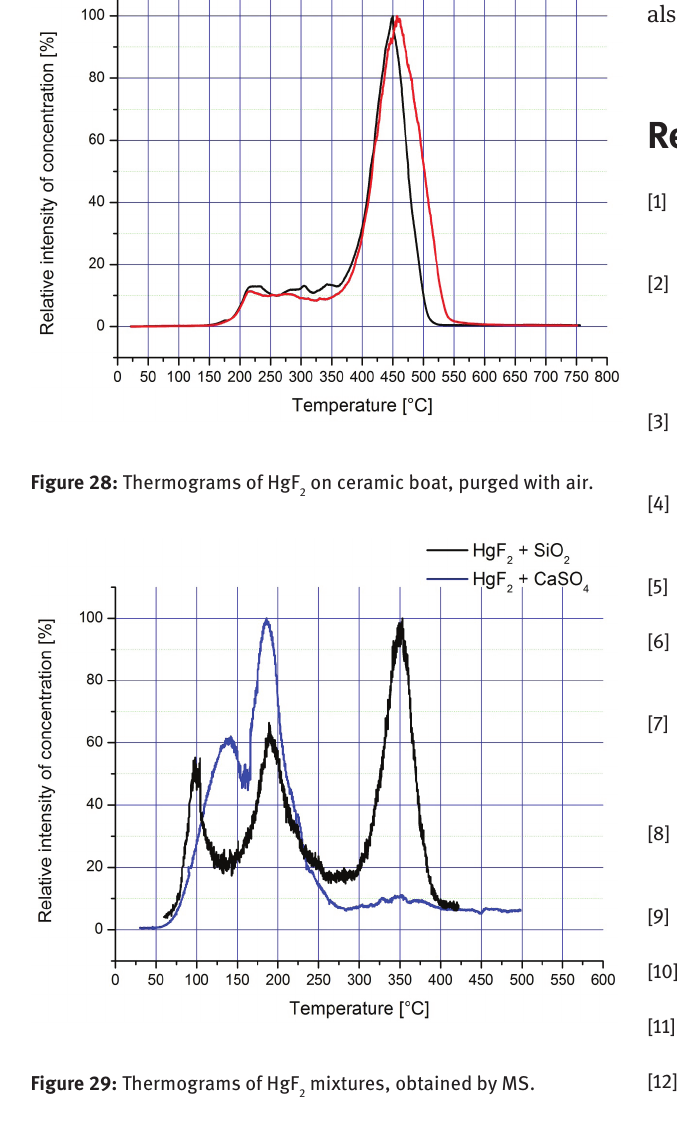
Figure 29: Thermograms of HgF